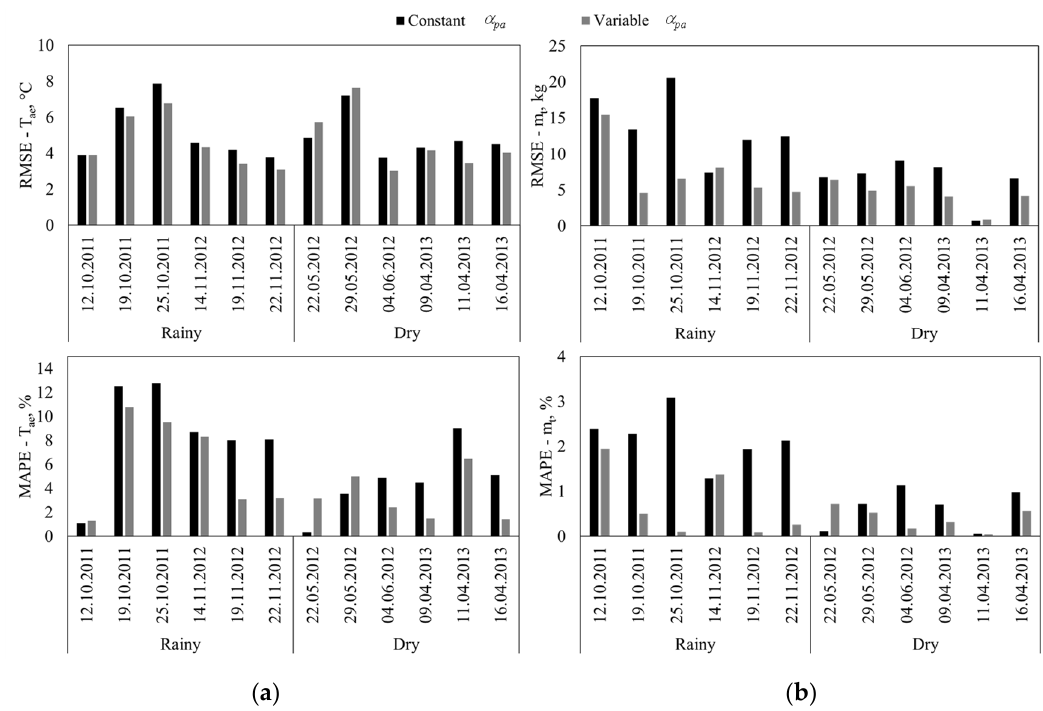
Figure 12. The lowest root mean square error RMSE and the mean absolute percentage error MAPE for constant and variable albedo α pa for exit temperature T ae ( a ) and for predicted instantaneous mass m t ( b ) during the rainy season and dry season.